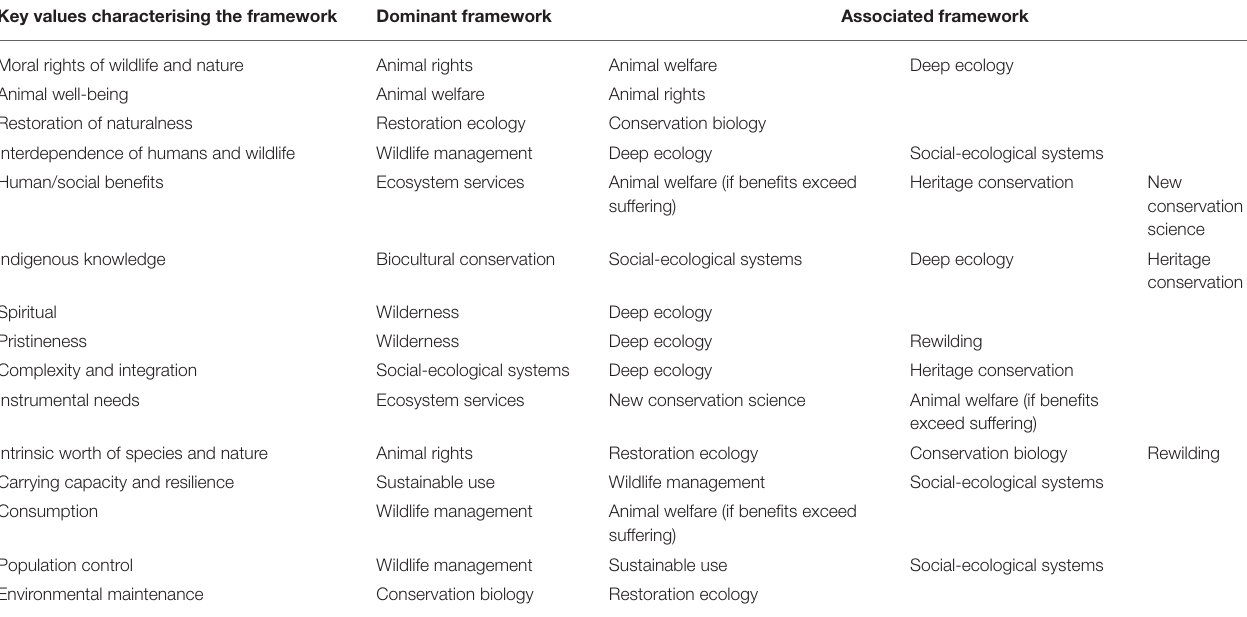
TABLE 3 | Relationship between key values and conceptual frameworks (the dominant framework with respect to key values in bold). Key values characterising the